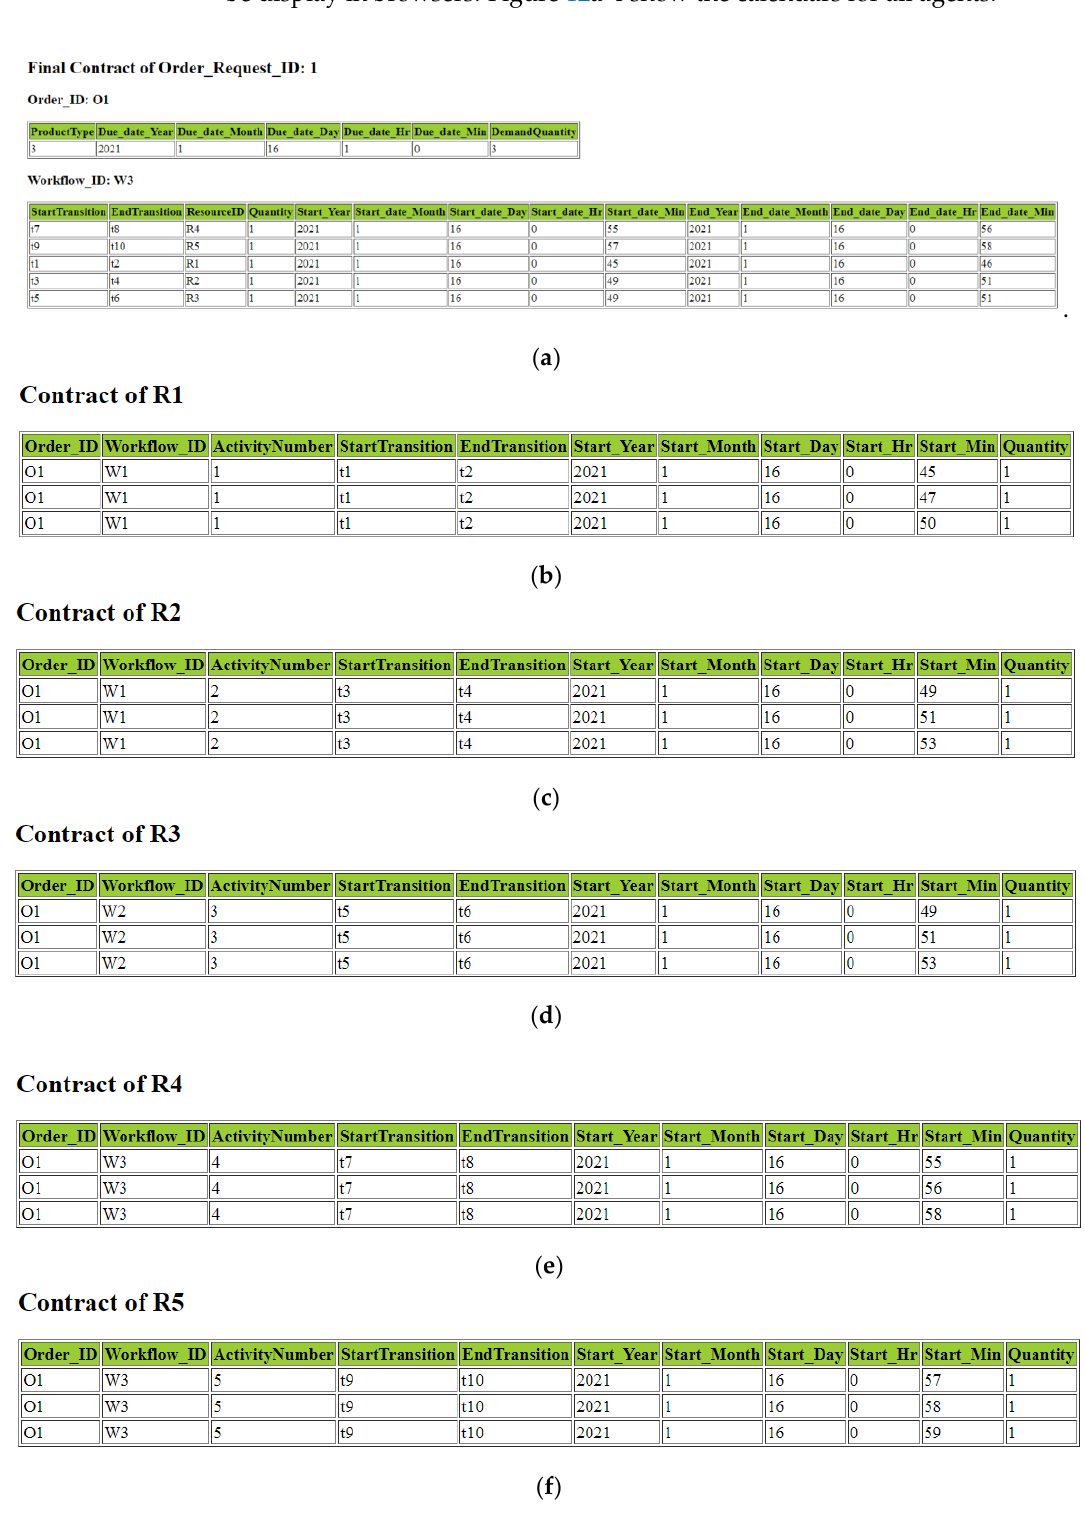
Figure 12. ( a ) Contract of an Order; ( b ) Contract of R1; ( c ) Contract of R2; ( d ) Contract of R3; ( e ) Contract of R4; ( f ) Contract of R5.